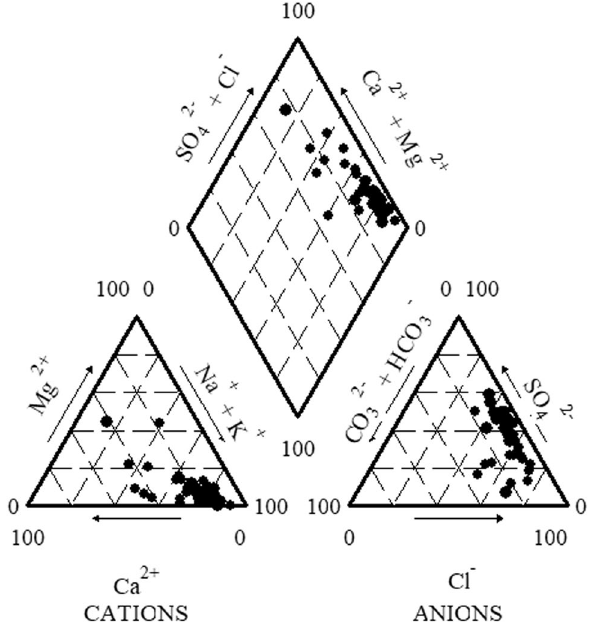
Fig. 4 Piper diagram representing the major geochemical facies of groundwater resources for the habitations in the study area